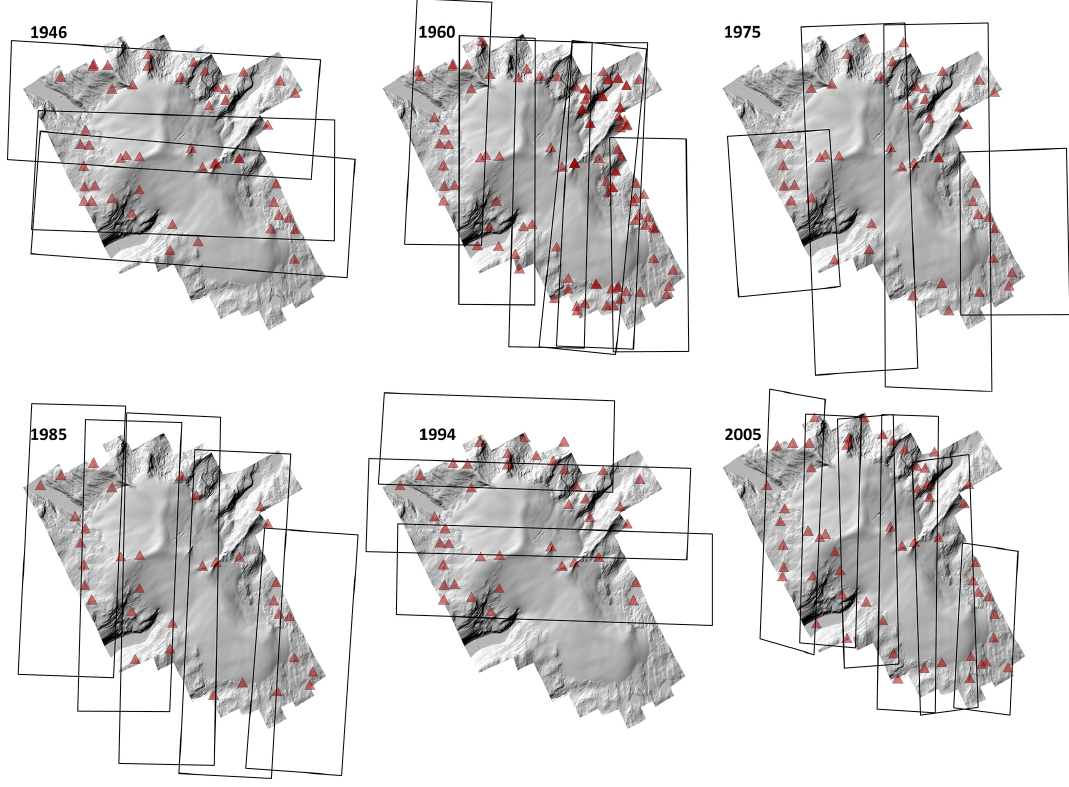
Figure 2. The coverage of aerial photographs (black line boxes) at different epochs with the lidar DEM as background. The GCPs used for orientation of each series of aerial photographs are marked with